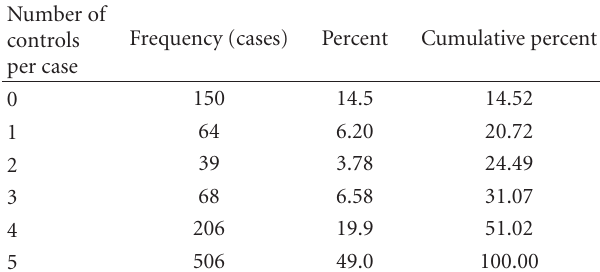
Table 2: Distribution of number of controls per